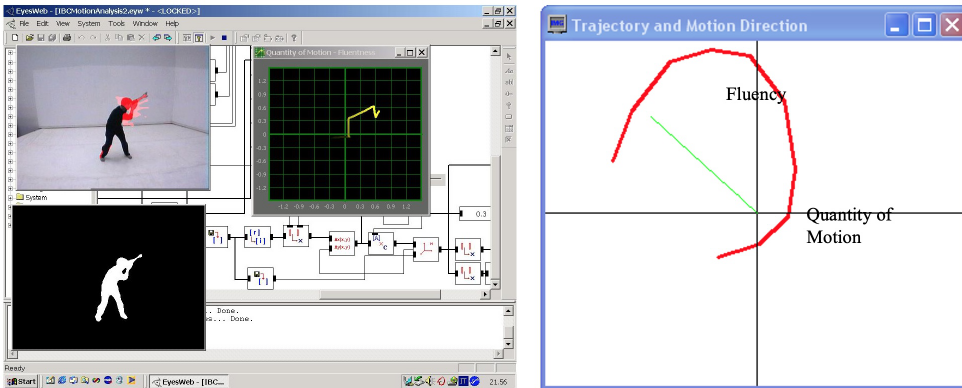
Figure 22. Interactive multimedia installation Pinocchio’s Square , exhibited at the Expo 2002 in Neuchâtel, Switzerland, from May to October 2002. One of the EyesWeb patches used during the exhibition, which maps expressive gestures into the Fluency/Quantity-of-Motion mid-level